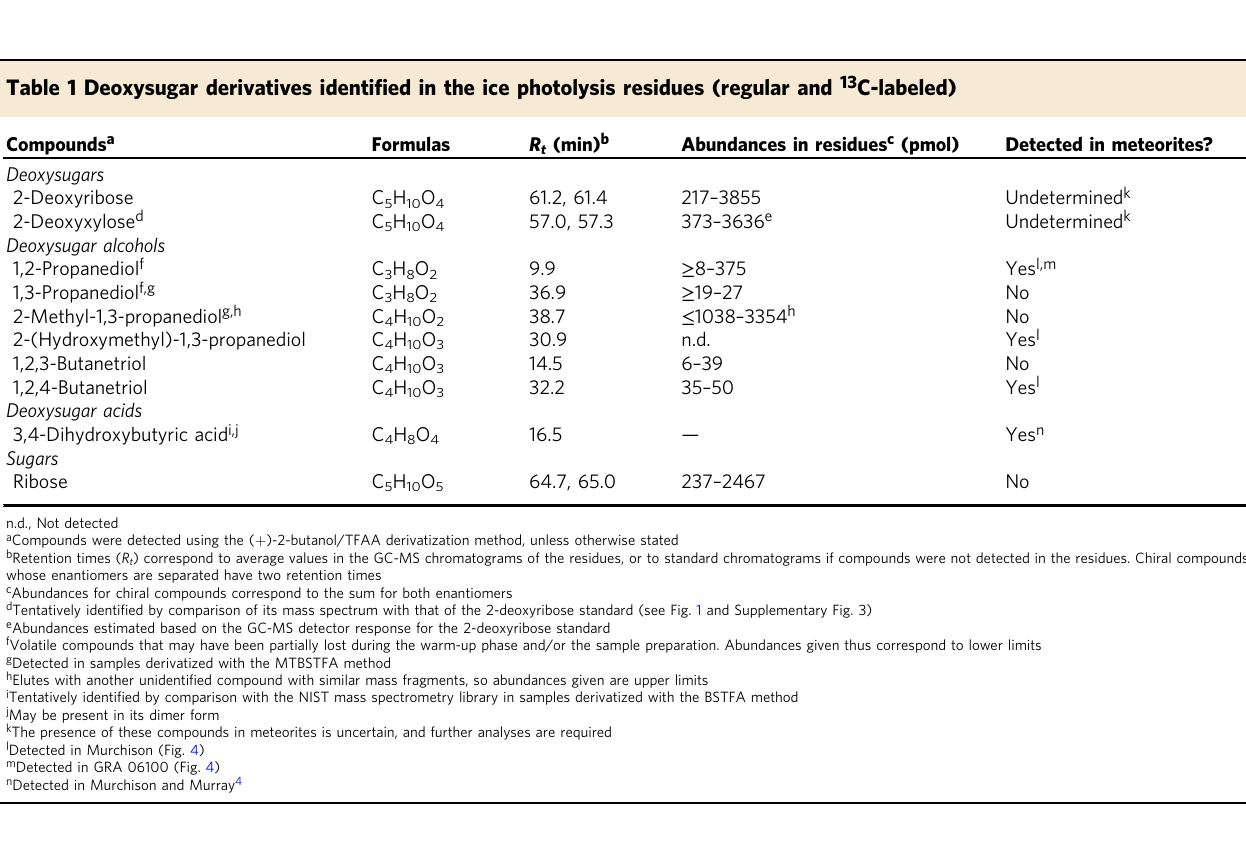
Fig. 2 Identi fi cation of the 4C deoxysugar alcohols 2-methyl-1,3-propanediol, 1,2,3-butanetriol, and 1,2,4-butanetriol in ice photolysis residues. a SIM chromatograms of residues produced from the UV irradiation of H 2 O:CH 3 OH (2:1) ( 12 C sample, m / z = 261 Da) and H 2 O: 13 CH 3 OH (2:1) ( 13 C sample, 264 Da) ice mixtures after derivatization with MTBSTFA. Intensities are offset for clarity. b From top to bottom, mass spectra of the peaks assigned to 2- methyl-1,3-propanediol in the regular residue, the 13 C-labeled residue, and a standard of 2-methyl-1,3-propanediol. The difference in relative intensities for the peaks at 133 and 261 Da suggests a coelution with an unidenti fi ed compound with similar mass fragments. c SIM chromatograms of the same regular (141 Da) and 13 C-labeled (143 Da) residues after derivatization with ( + )-2-butanol/TFAA. Intensities are offset for clarity. d From top to bottom, mass spectra of the peaks assigned to 1,2,3-butanetriol in the regular residue, the 13 C-labeled residue, and a standard of 1,2,3-butanetriol. e SIM chromatograms of the same regular (153 Da) and 13 C-labeled (156 Da) residues after derivatization with ( + )-2-butanol/TFAA. Intensities are offset for clarity. f From top to bottom, mass spectra of the peaks assigned to 1,2,4-butanetriol in the regular residue, the 13 C-labeled residue, and a standard of 1,2,4-butanetriol. Molecular structures are shown without derivatization. Assignments of the fragments in the mass spectra can be found in Supplementary Table 1